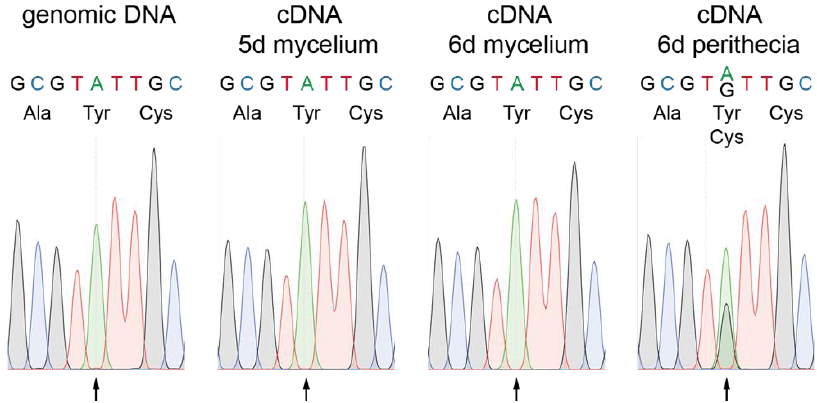
Figure 2. Verification of RNA editing in pro34 . PCR fragments were generated from genomic DNA or cDNA from samples as indicated and subjected to Sanger sequencing. For each condition, chromatograms of the editing site codon and one codon up- and downstream are shown. The arrow indicates the RNA editing site at position 2562 of the pro34 transcript. Coded amino acids are given below the DNA sequence.